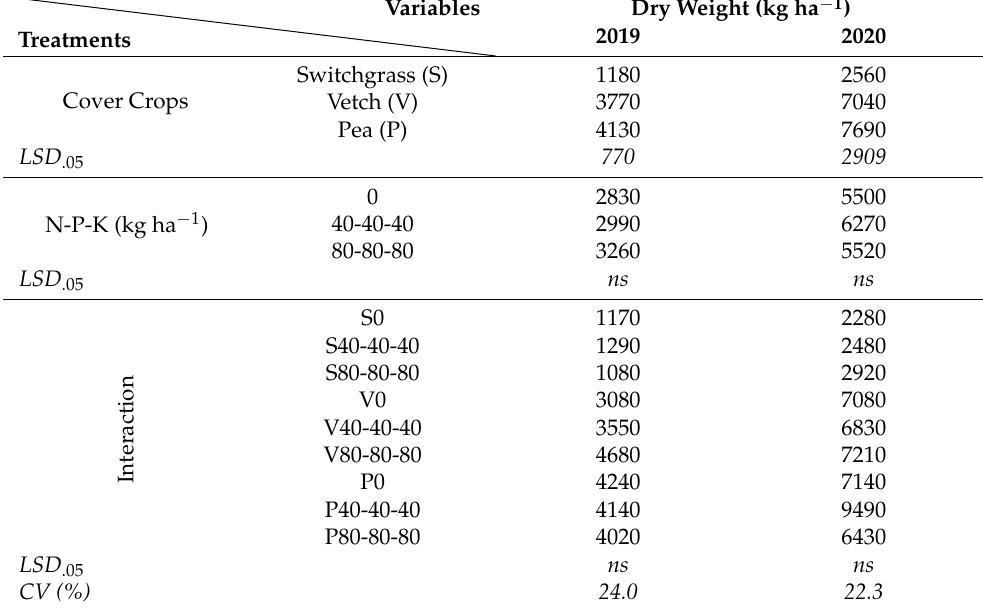
Table 1. Dry biomass yield of switchgrass in a monoculture and co-culture system of vetch or pea during 2019 and 2020. Variables 2019 Treatments Switchgrass Cover Crops